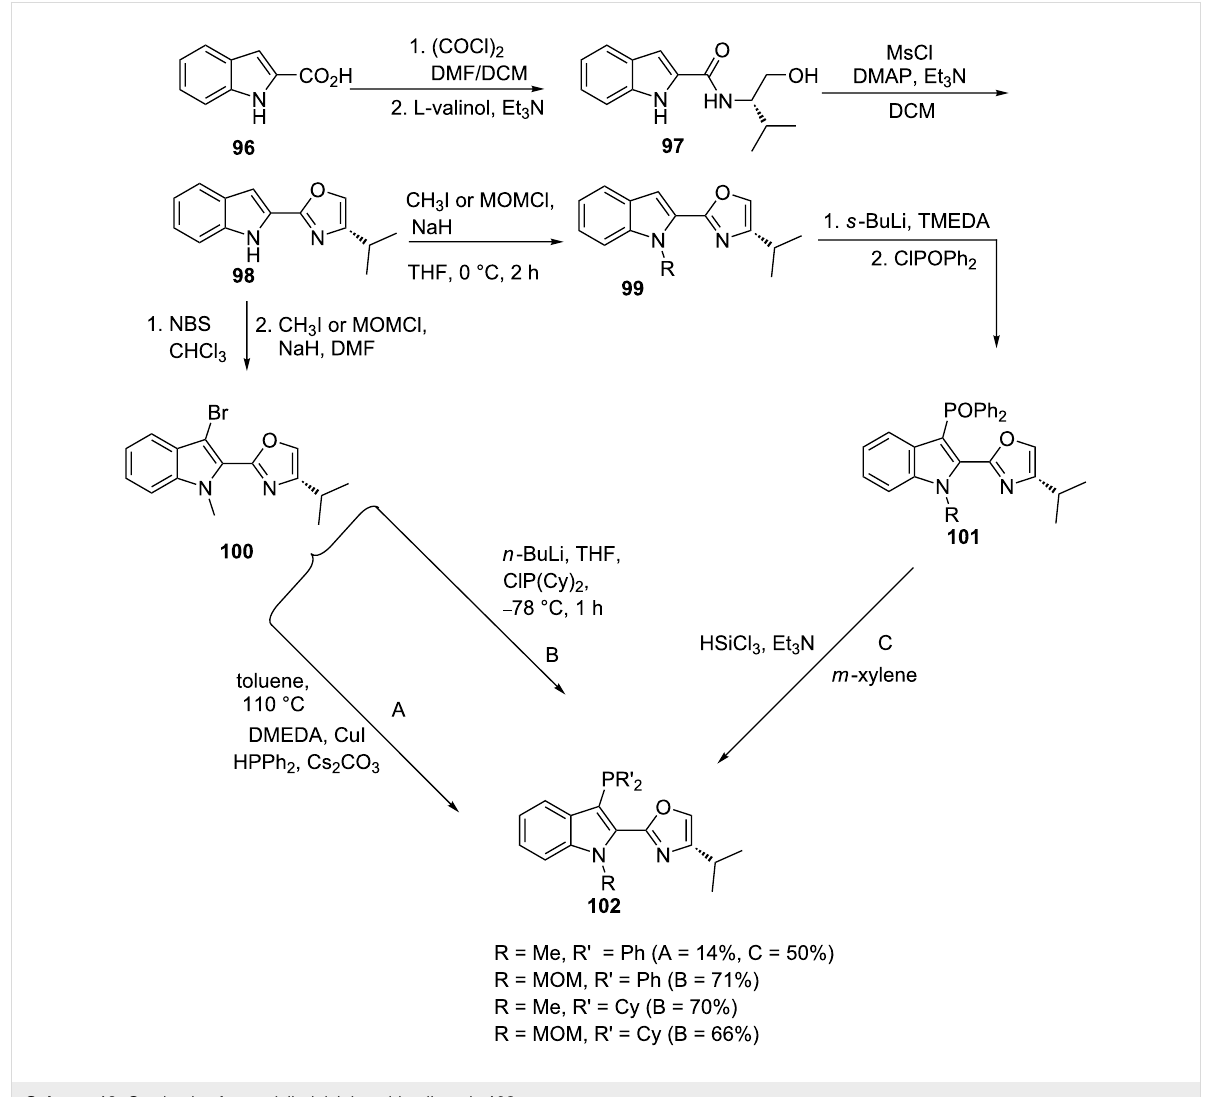
Scheme 18: Synthesis of oxazolylindolylphosphine ligands 102